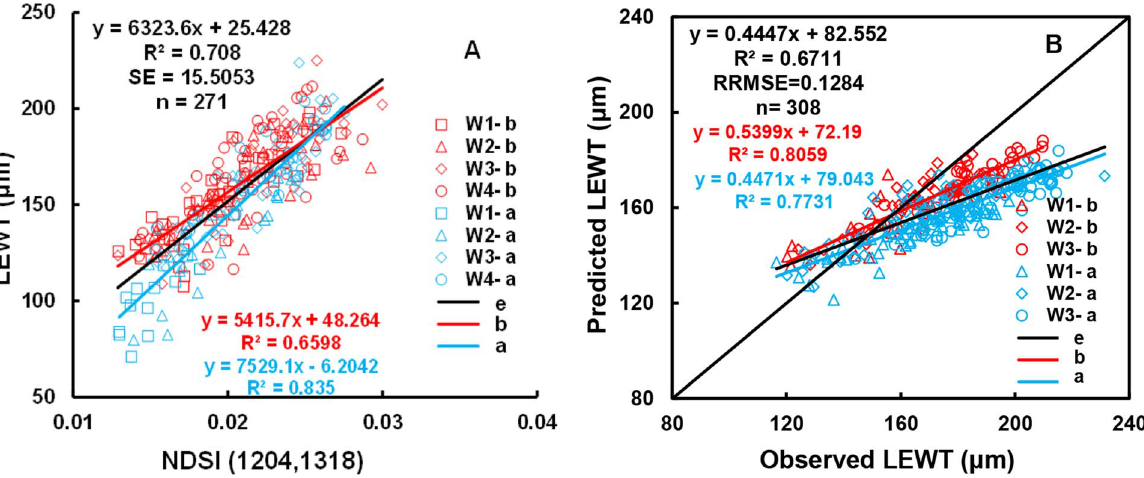
Figure 5. Quantitative relationships between NDSI (R 1204 , R 1318 ) and LEWT (A); the 1:1 relationship between the predicted and observed LEWT based on NDSI (R 1204 , R 1318 ) (B).